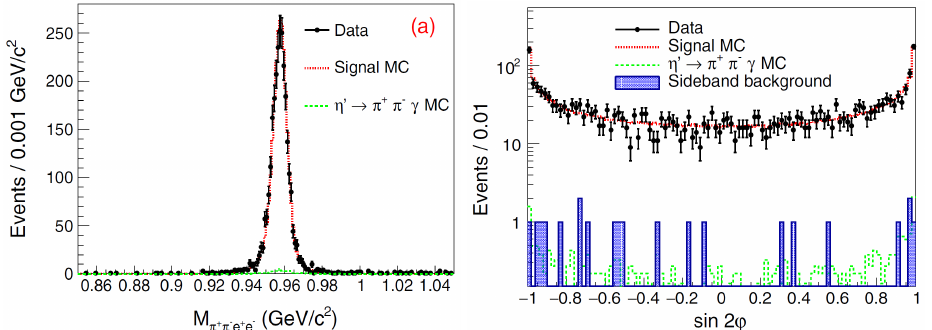
Figure 2: The π + π − e + e − invariant mass spectrum around η (cid:48) mass (left) and the sin2 φ distribution in the signal region (right). The dots with error bars are data, the red histograms are signal MC, and other histograms are representing for back- grounds. The plot is reproduced from Ref [ 8 ] under the Creative Commons Attribu- tion 4.0 International